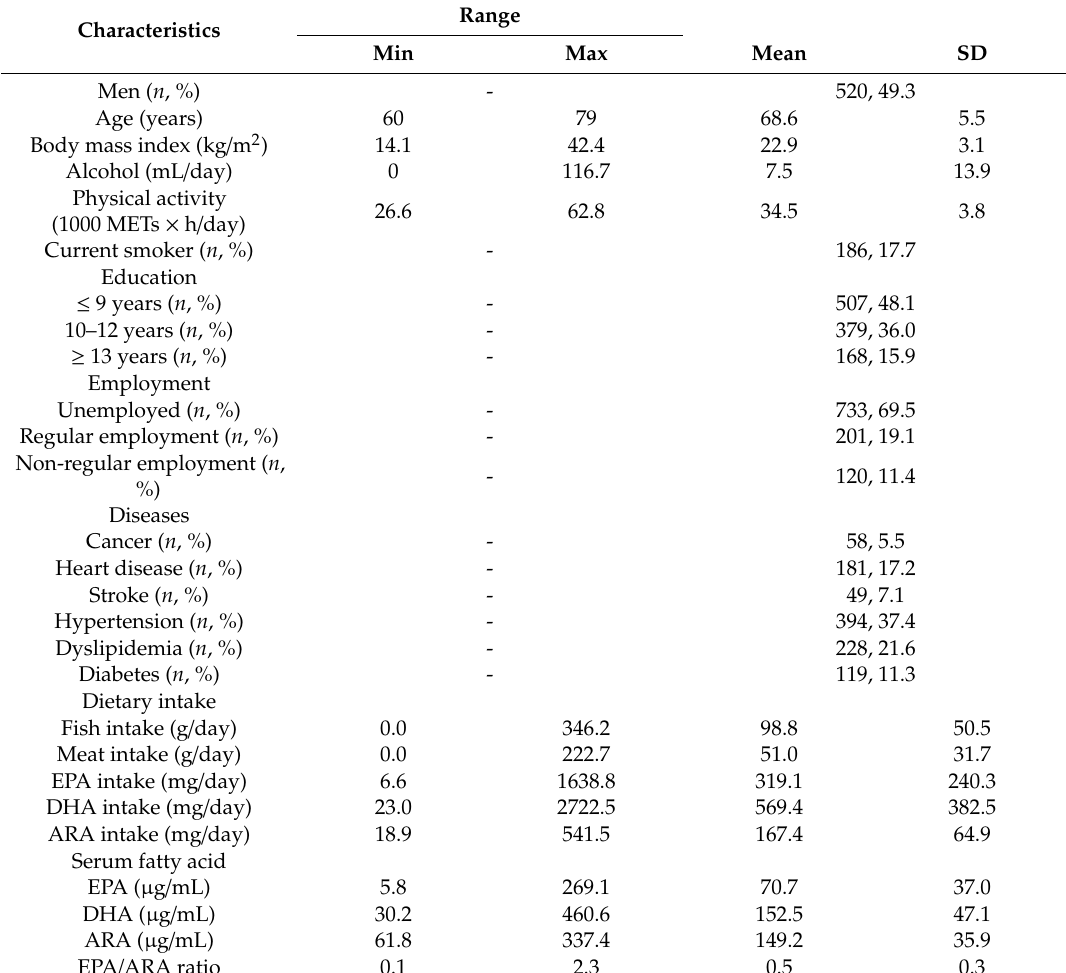
Table 1. Baseline characteristics of participants ( n =